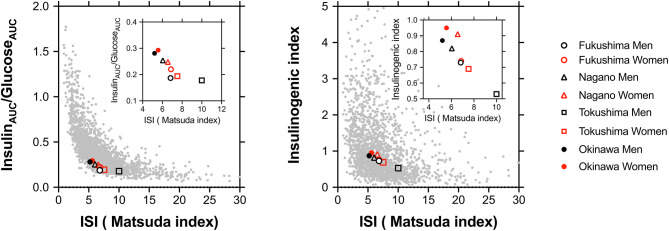
The plot between the insulin sensitivity index (ISI; Matsuda index) and insulinAUC/glucoseAUC (left panel) or the insulinogenic index (right panel) in all participants including those from four regions. The stabilization points of insulin sensitivity and the insulin response are depicted on plots in all participants and are shown in the inset as Fukushima men (°) and women (°), Nagano men (Δ) and women (Δ), Tokushima men (□) and women (□), and Okinawa men (•) and women (•).